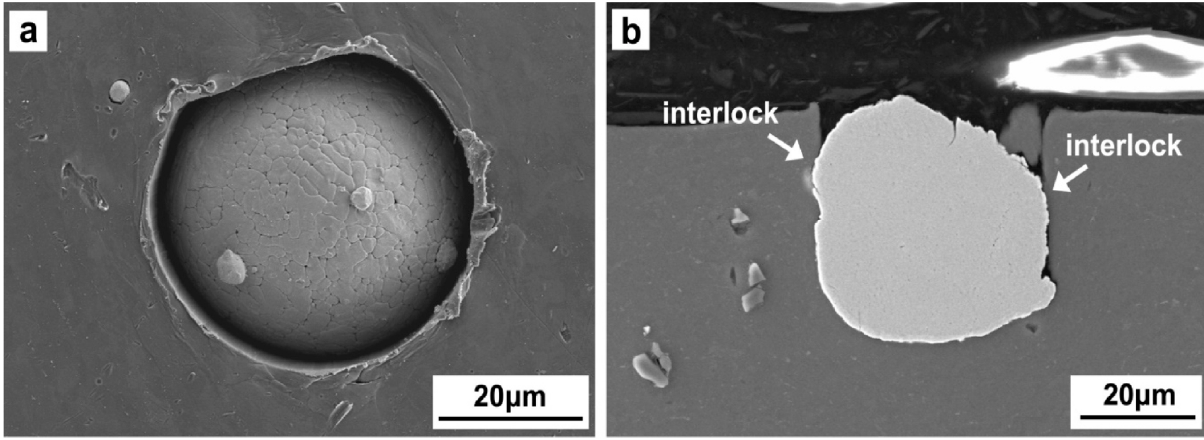
Figure 17. Microstructural characterization of Cantor alloy deposited on Al 6082 substrate showing ( a ) surface morphology and ( b ) cross-sectional view with the mechanical interlocking phenomena. Reprinted/adapted with permission from Ref. [200]. Copyright 2019, Elsevier.